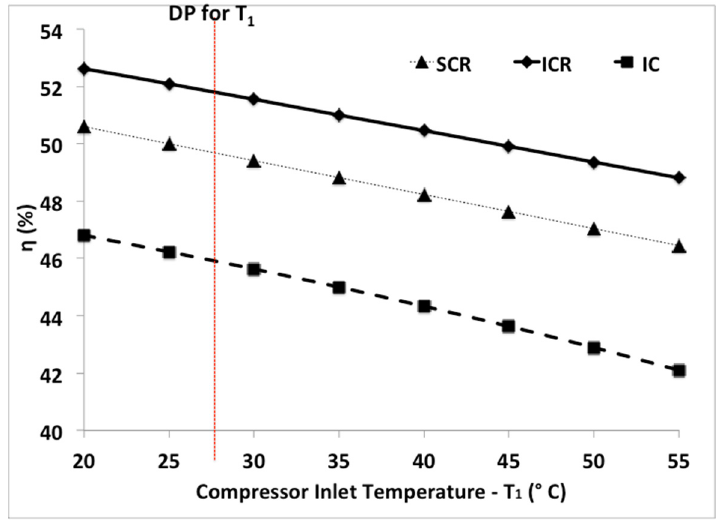
Figure 12. Effect of Cycle Inlet Temperature ( T 1 ) on Cycle Efficiencies. The trend shows decreasing efficiencies for all the cycles as the cycle inlet temperature increases.